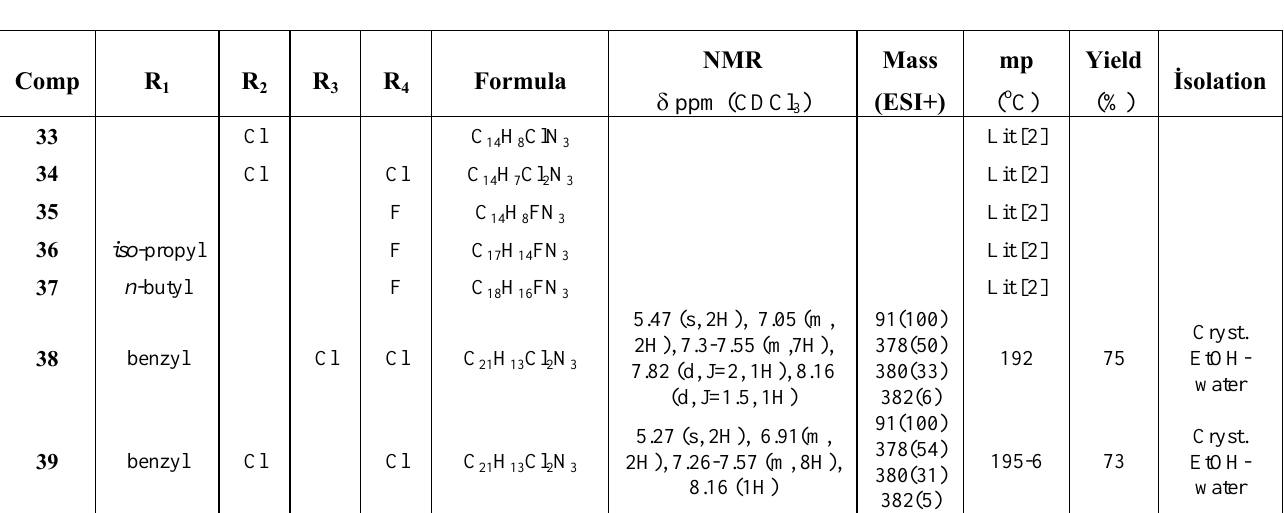
Table 6 . Formulas, spectroscopic data, mp and yields of 33 - 39